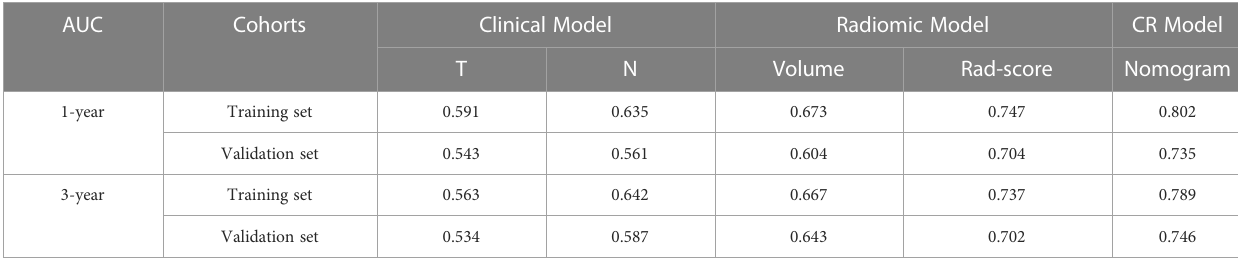
TABLE 4 Compare with clinical and radiomic model predicting OS of LC